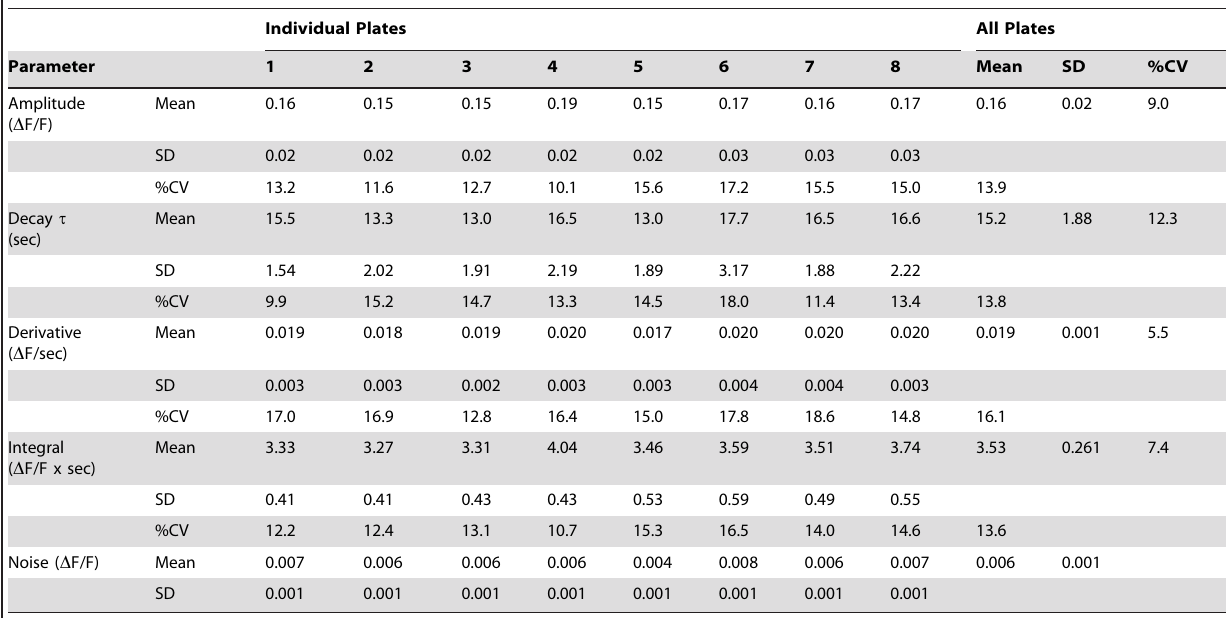
Table 1. MANTRA system signal uniformity analysis.